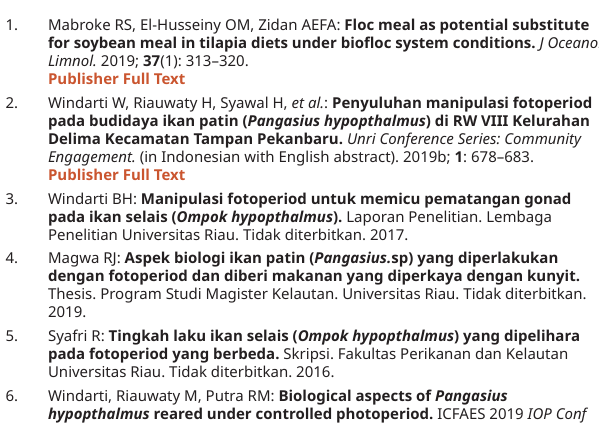
Figshare: Tissue structure, https://doi.org/10.6084/m9.figshare. 13602104.v1 24